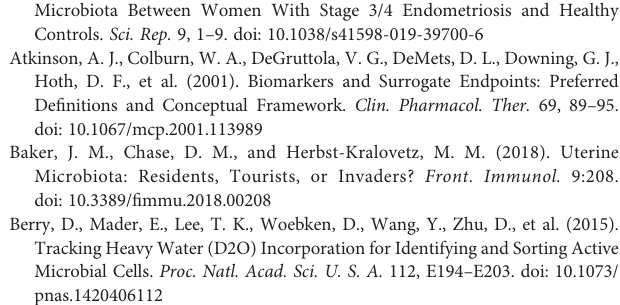
Supplementary Figure 6 | is related to Figure 5 . Models trained on indicator species to predict EM. (A) Heatmap of indicator taxa de fi ned by the indicator value. (B – D) Curves of receiver operating characteristics for classi fi cation of EM based on indicator taxashown in the heatmap above. (E – G) Venn diagrams show the overlap taxa between random forest selected species and indicator taxa of different body